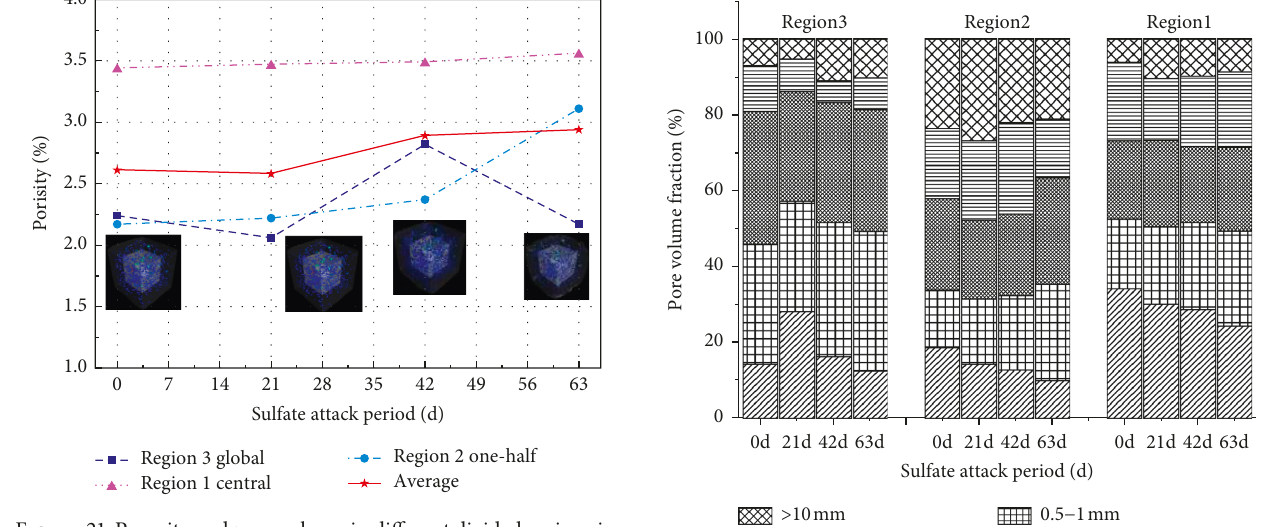
Figure 21: Porosity and pore volume in different divided regions in specimens exposed to drying-wetting cycles with sulfate attack. specimens exposed to drying-wetting cycles with sulfate attack.